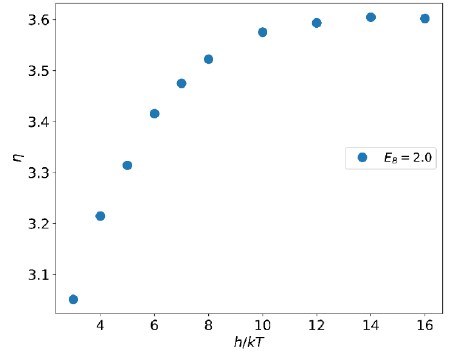
Figure 12. Dependence of the viscosity 𝜂 on the reversible bond strength, ℎ .